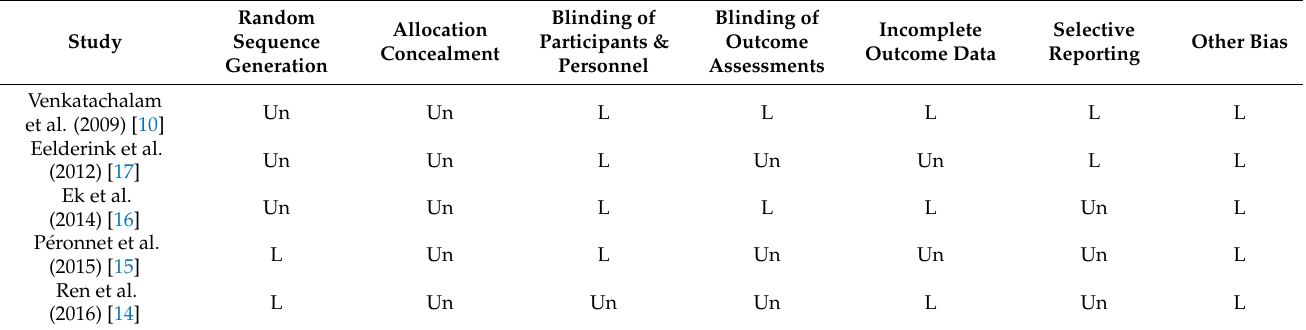
Table 2. Assessment of risk of bias in the included studies using Cochrane